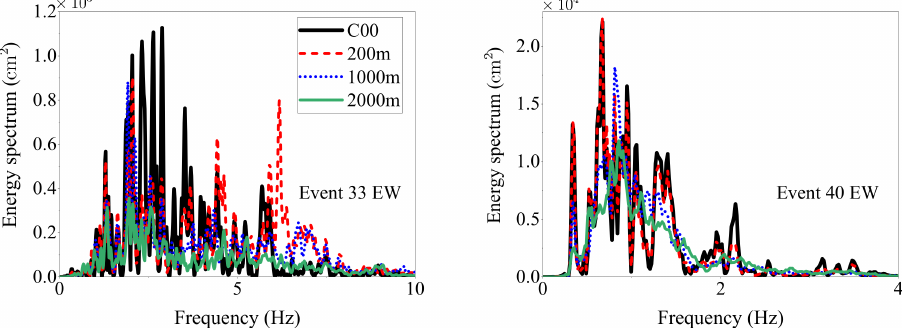
Figure 13. Evolution of the average